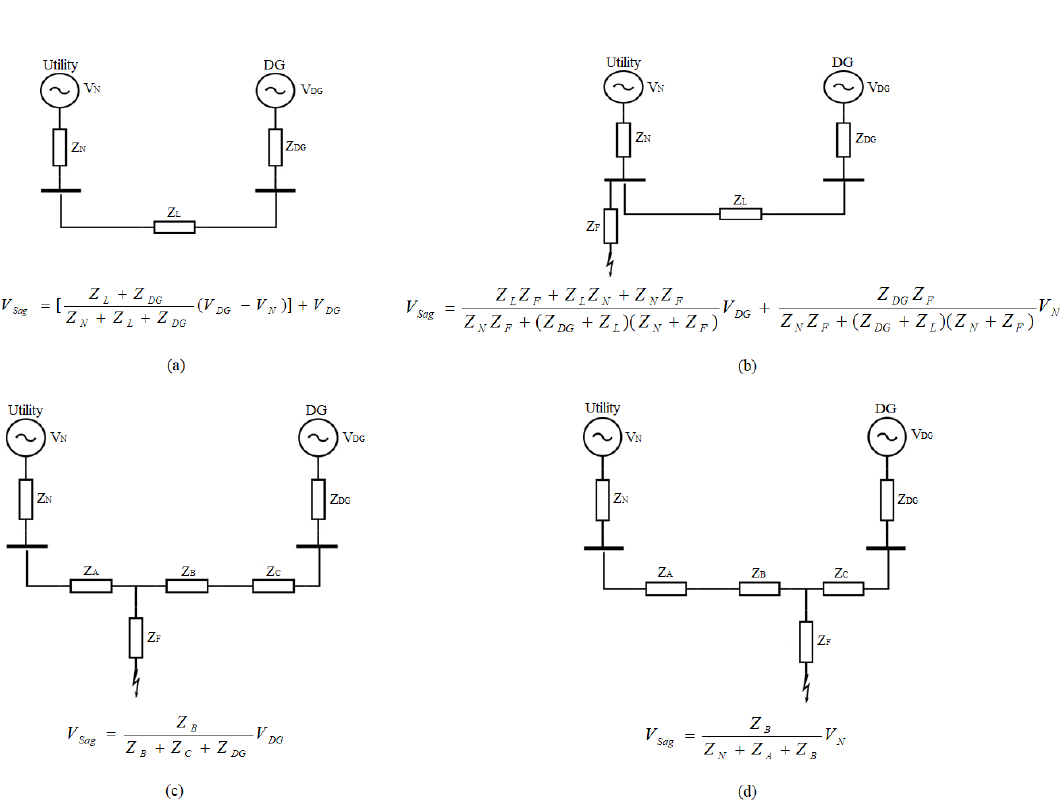
Figure 3. Different system contingencies and associated voltage sag estimations. ( a ) Normal condition, ( b ) fault condition at the utility bus, ( c ) fault condition for the transmission network near the utility, and ( d ) fault condition for the transmission network near the